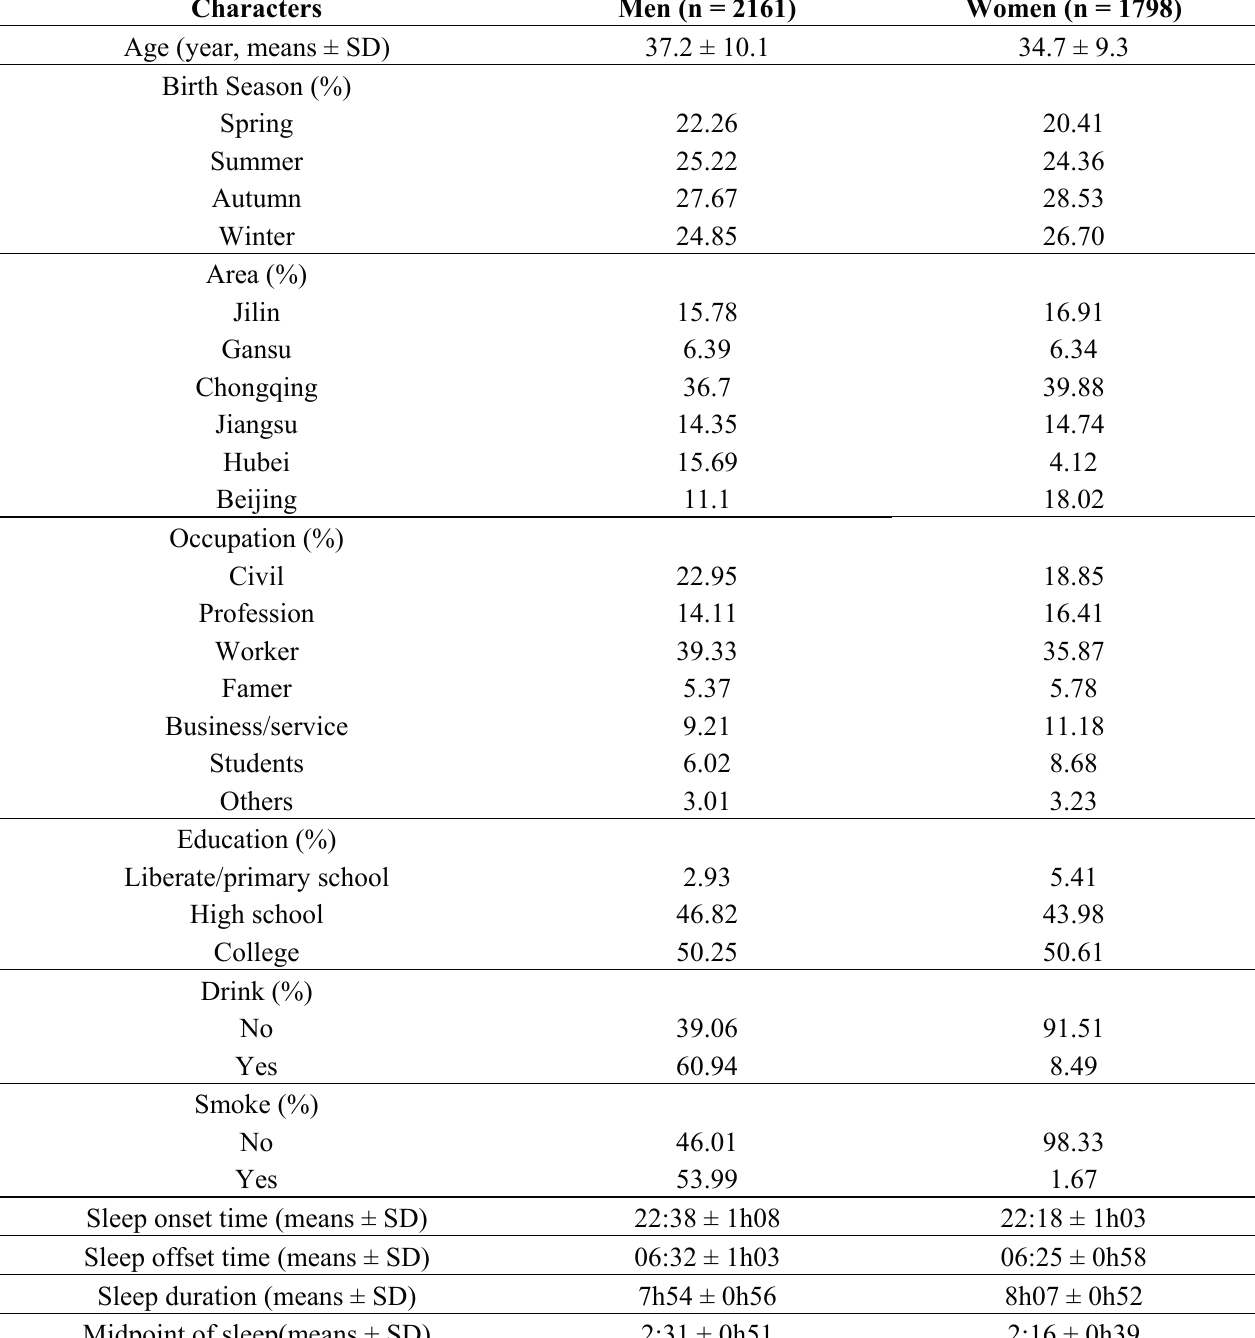
Table 1. Demography and socioeconomic characters among Chinese adults by